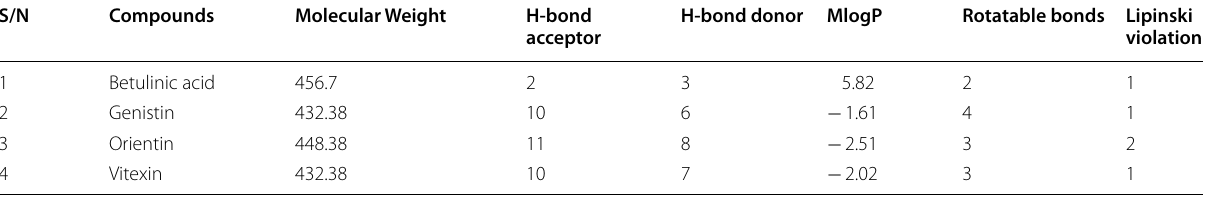
MLOGP: octanol/water partition coefficient